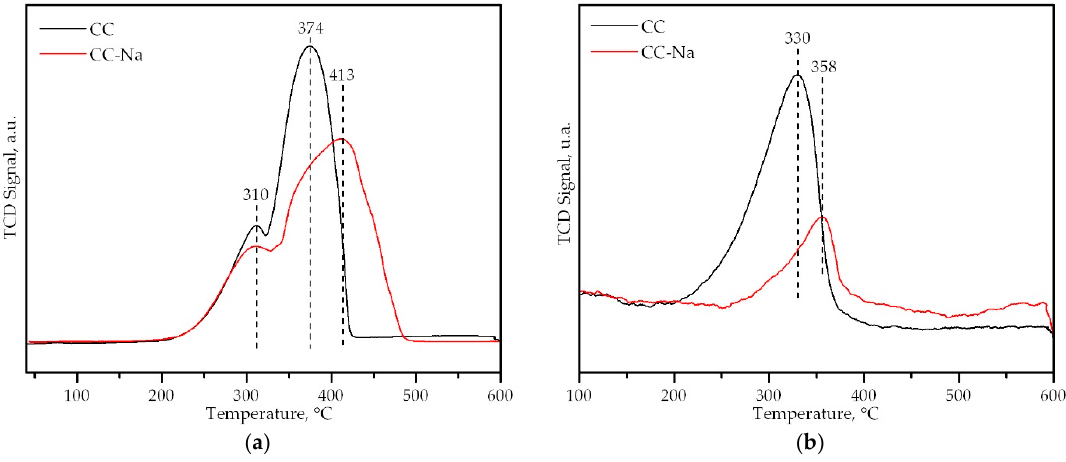
Figure 7. ( a ) H 2 -TPR profiles of the samples; ( b ) O 2 -TPO profiles of the samples.